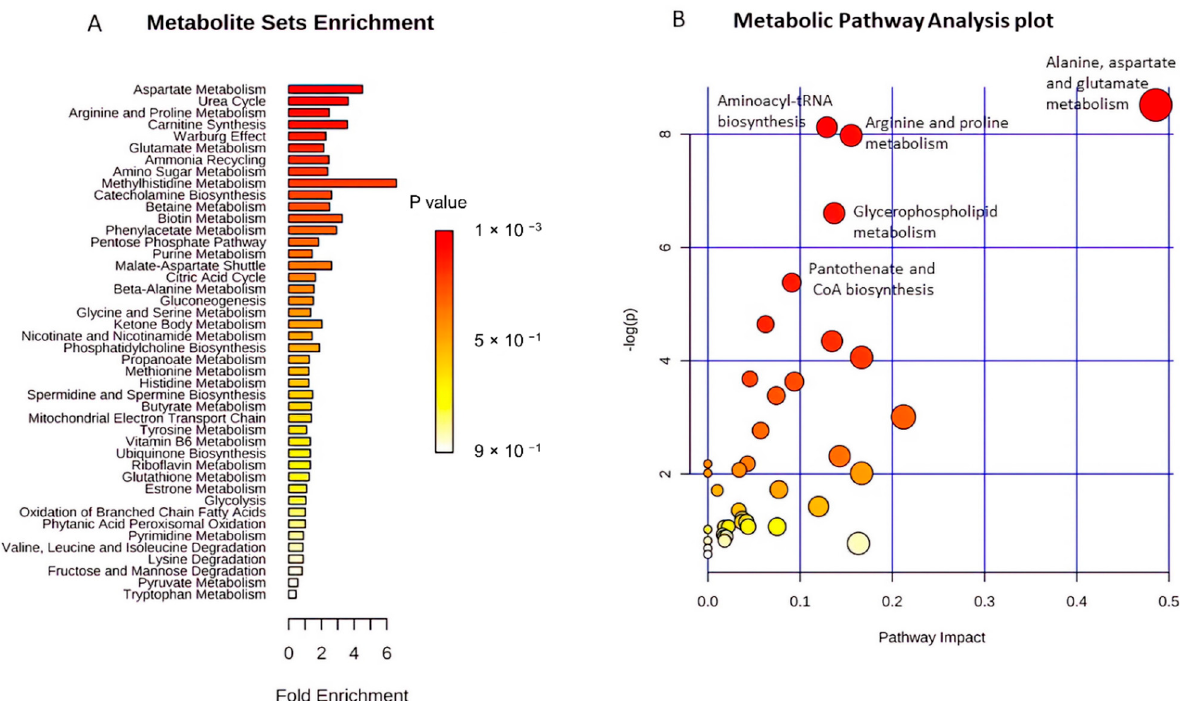
Figure 4. Metabolic pathways enriched in CCC patients compared to healthy controls. ( A ) Metabolic pathways enriched ordered by statistical significance, ( B ) functional analysis depicting enriched metabolic pathways according to pathway impact score.